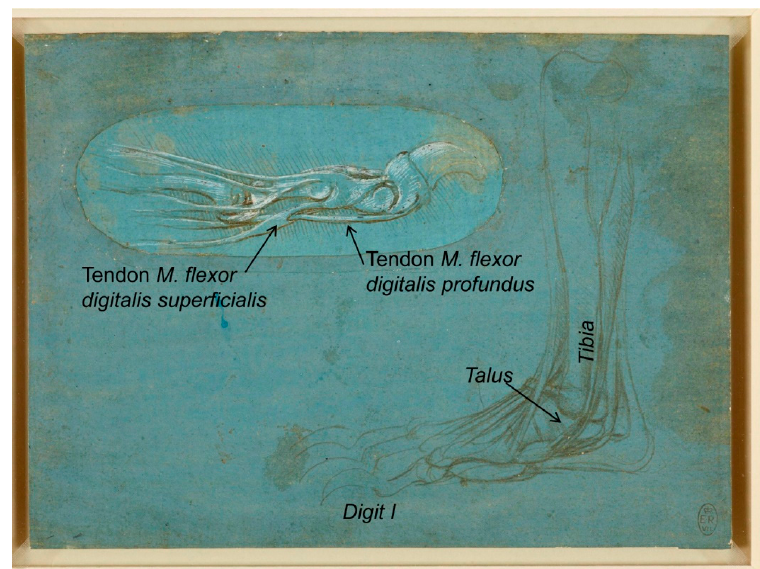
Figure 3. Bear’s foot series—Number 2. Upper left: Bear pes digit . Down right: Bear distal right pelvic limb/ pes , medial aspect. A bear’s foot c.1488–1490. Modified from www.rct.uk/collection/912373 Recto